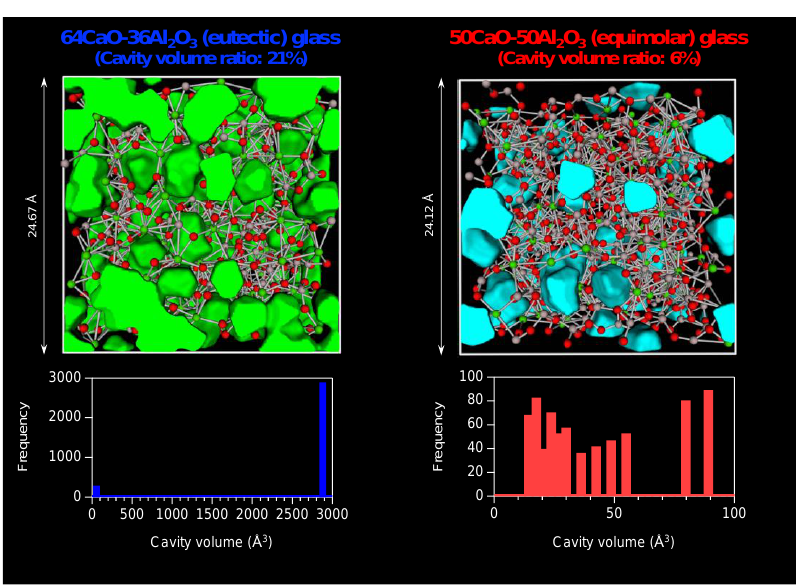
Figure 9. Atomic configurations with cavities and cavity volume histograms for CaO – Al 2 O 3 glasses.